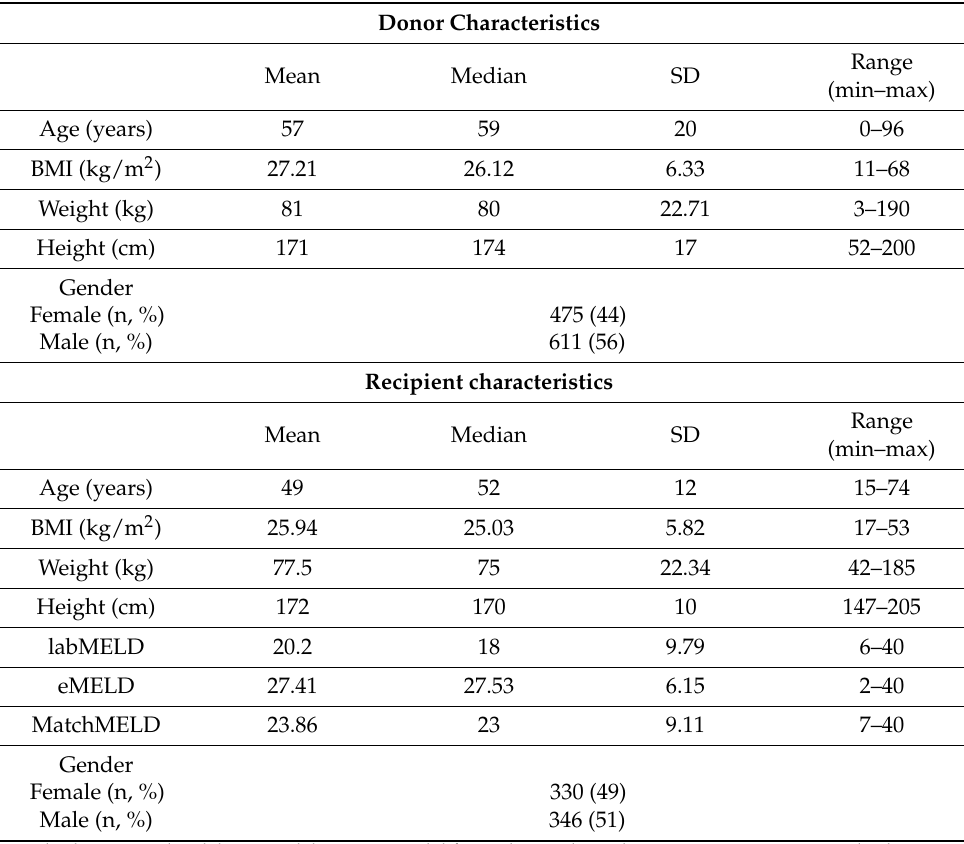
Table 1. Demographic characteristics and clinical donor and recipient